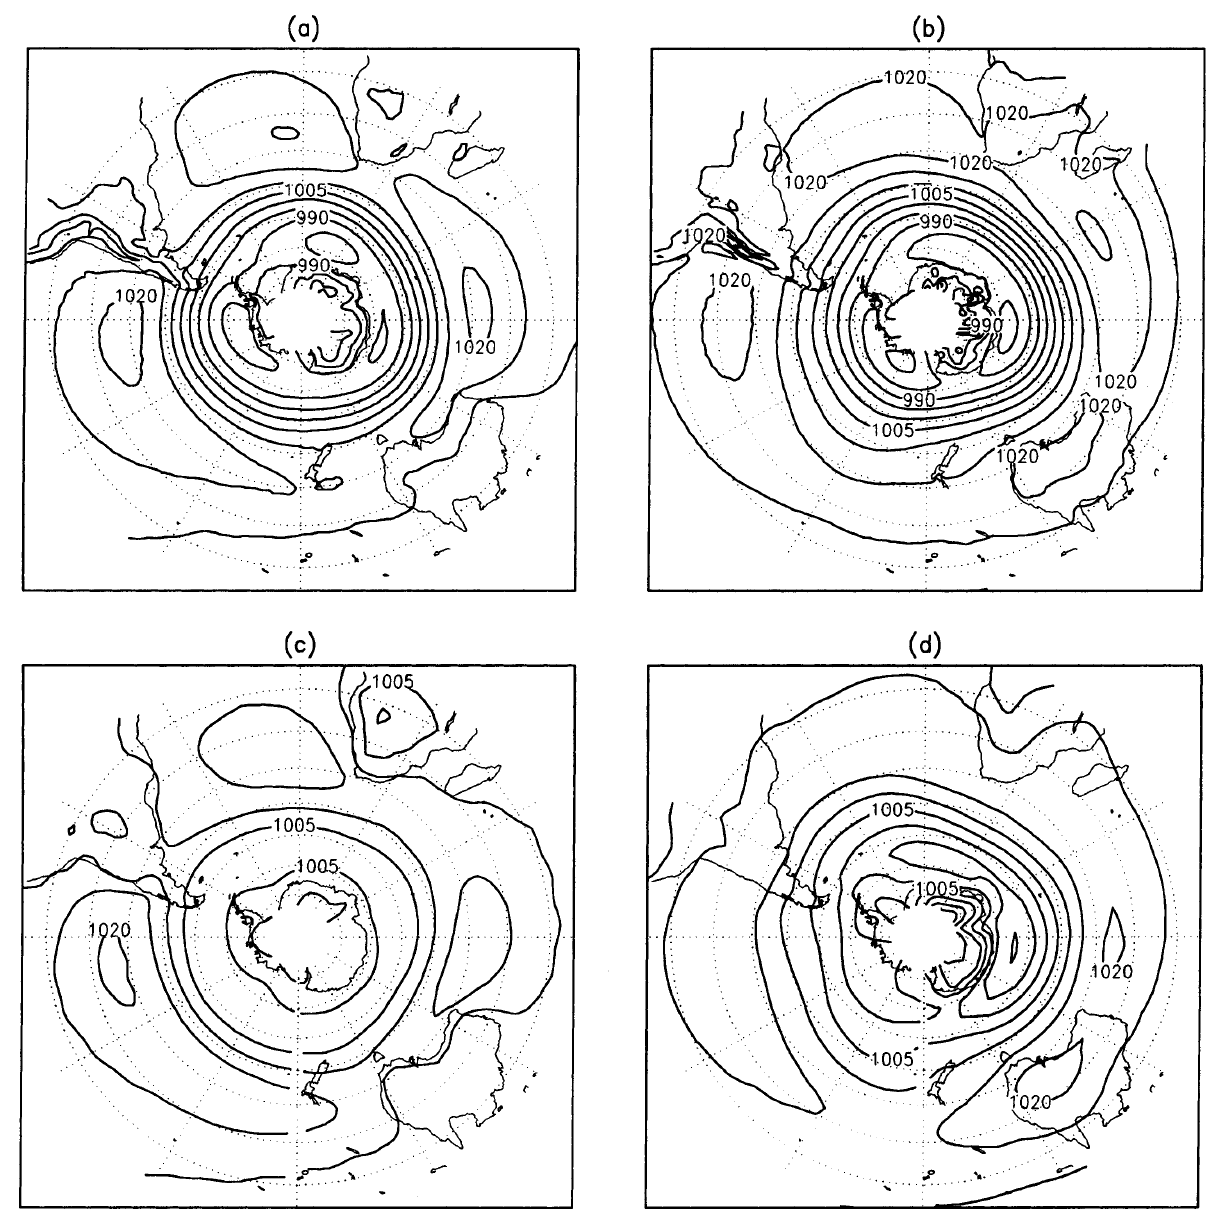
Fig. 1a–d. Mean sea level pressure from observations ( upper panels ) and the model ( lower panels ), for summer ( a, c ) and winter ( b, d ). Contour interval is 5